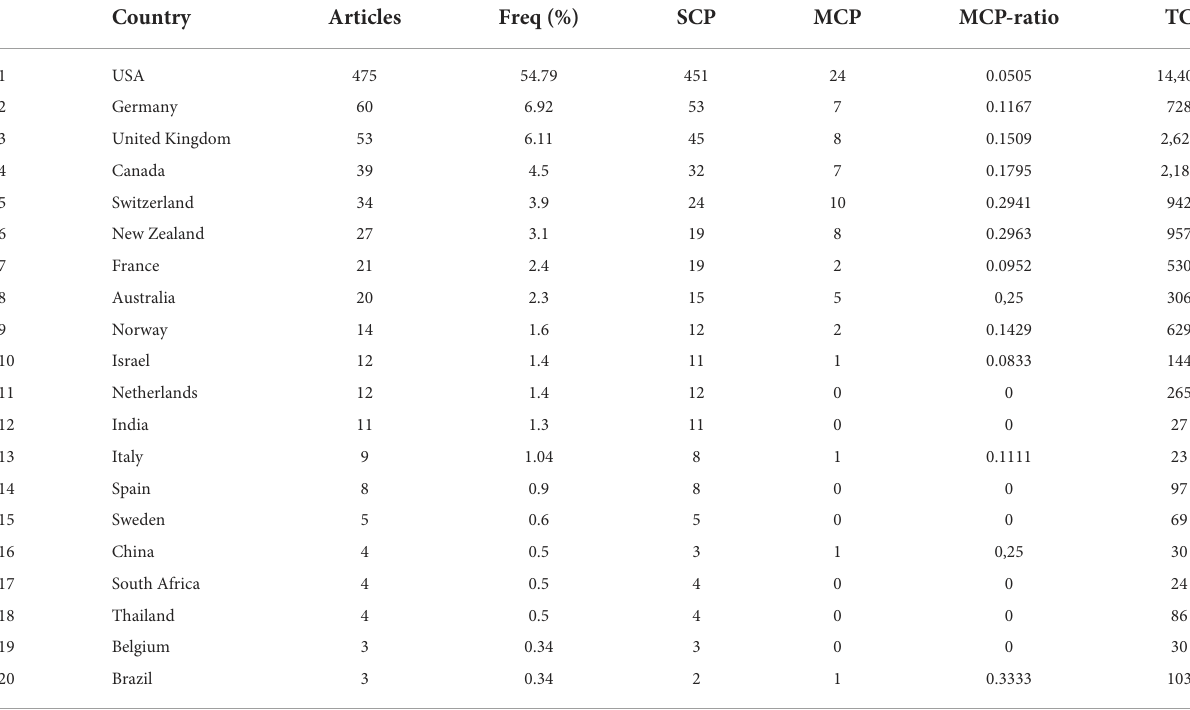
TABLE 4 Table, corresponding author’s country, publication activity and frequency of international collaboration (2000–2019). Country